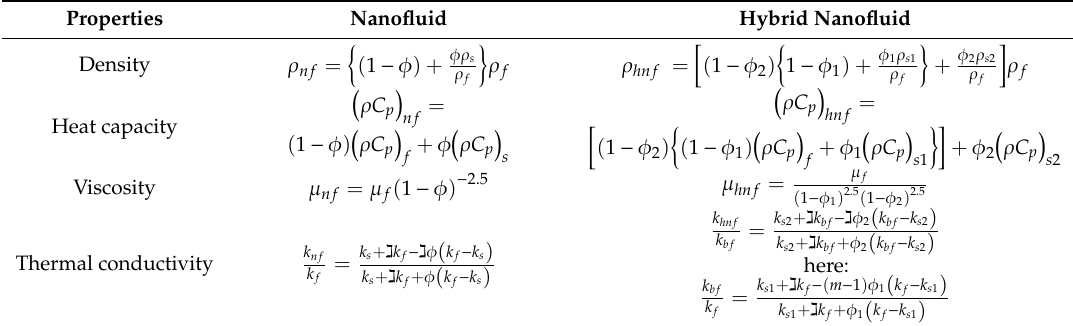
Table 1. E ff ective models for hybrid nanofluid characteristics.